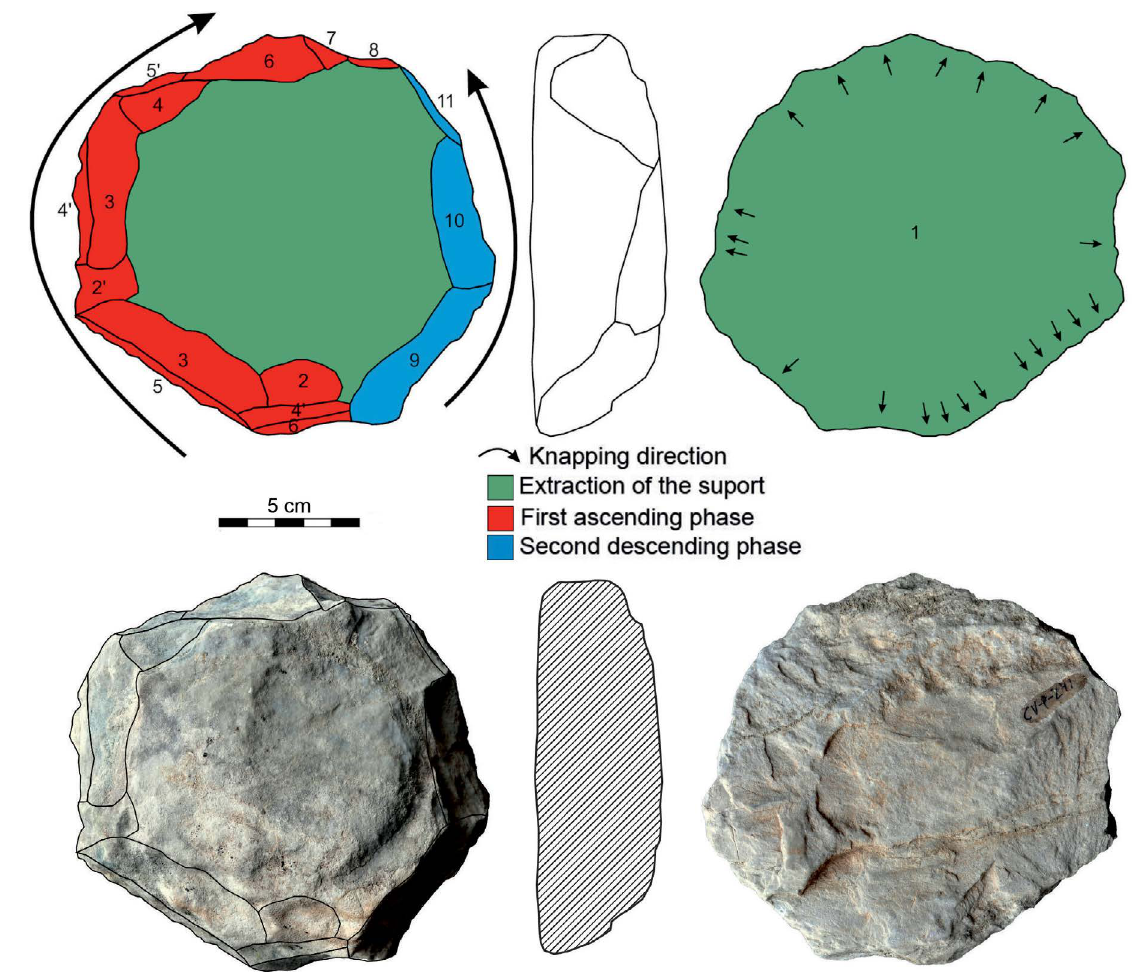
Figure 10. Diacritic scheme of knapping preform No.